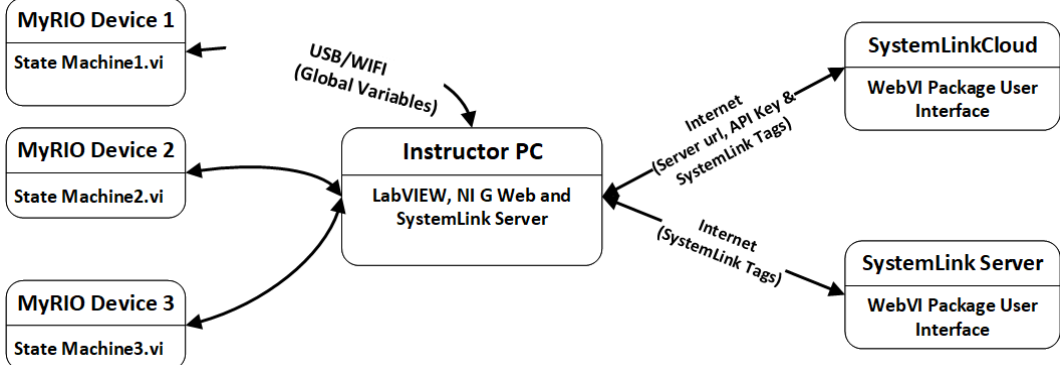
Figure 3. System interconnectivity.